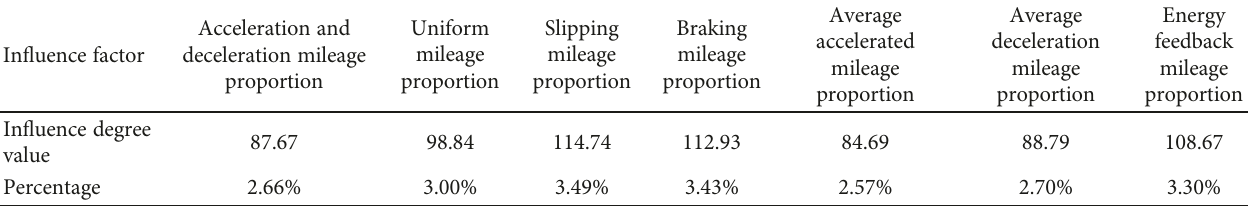
Table 4: The in fl uence degree of energy consumption in fl uence factors (driving actual service life characteristics).